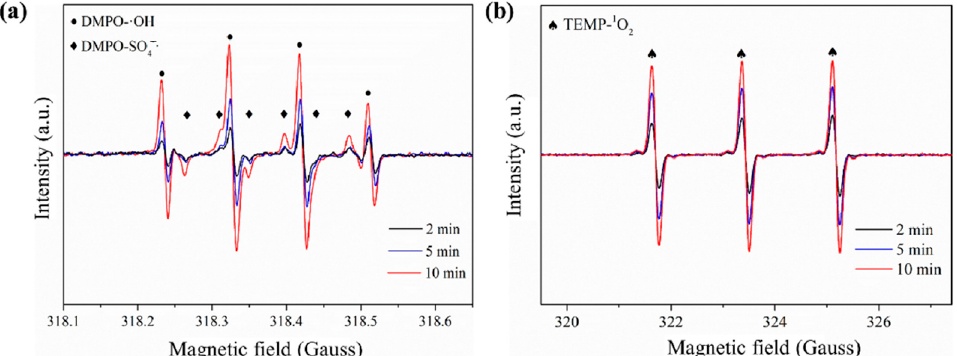
Figure 6. Detected ESR signals by using ( a ) DMPO and ( b ) TEMP as the spin trapping agents [56],